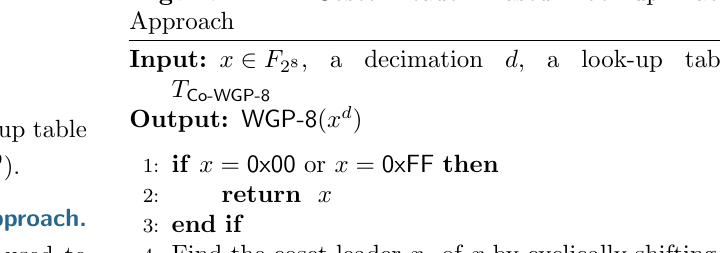
Algorithm 1 Coset Leader Based Look-up Table